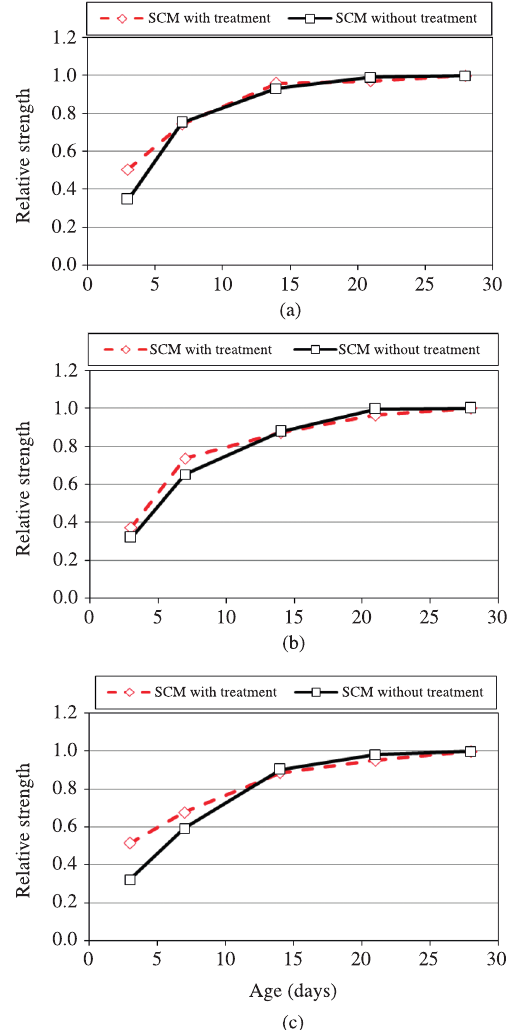
Figure 8. Development of relative strength on compressive of self- compacting mortars (a) SCM(R) (b) SCM(CS) (c)